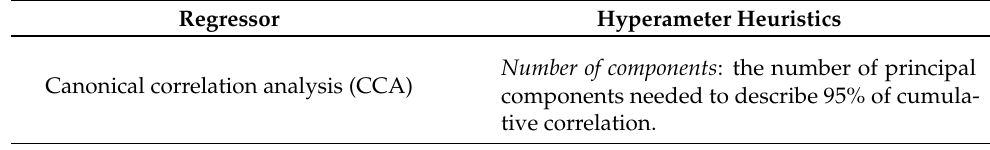
Table 5. Heuristics for setting hyperparameter values during unsupervised model